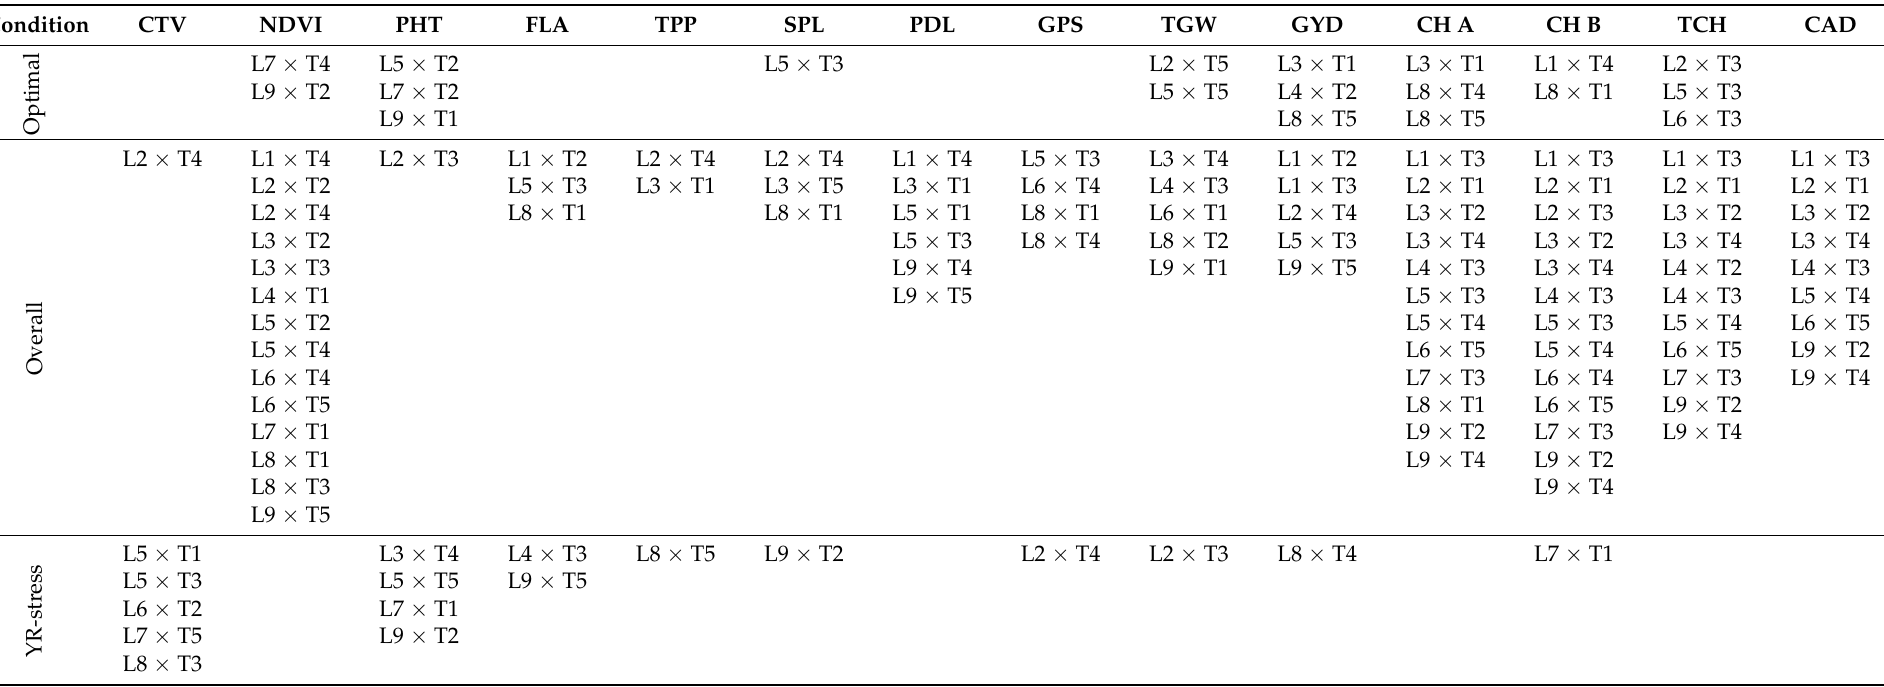
Table 5. Specific combining ability (SCA) estimates of crosses for physiological, grain yield, yield components and biochemical traits under optimal and YR- stress